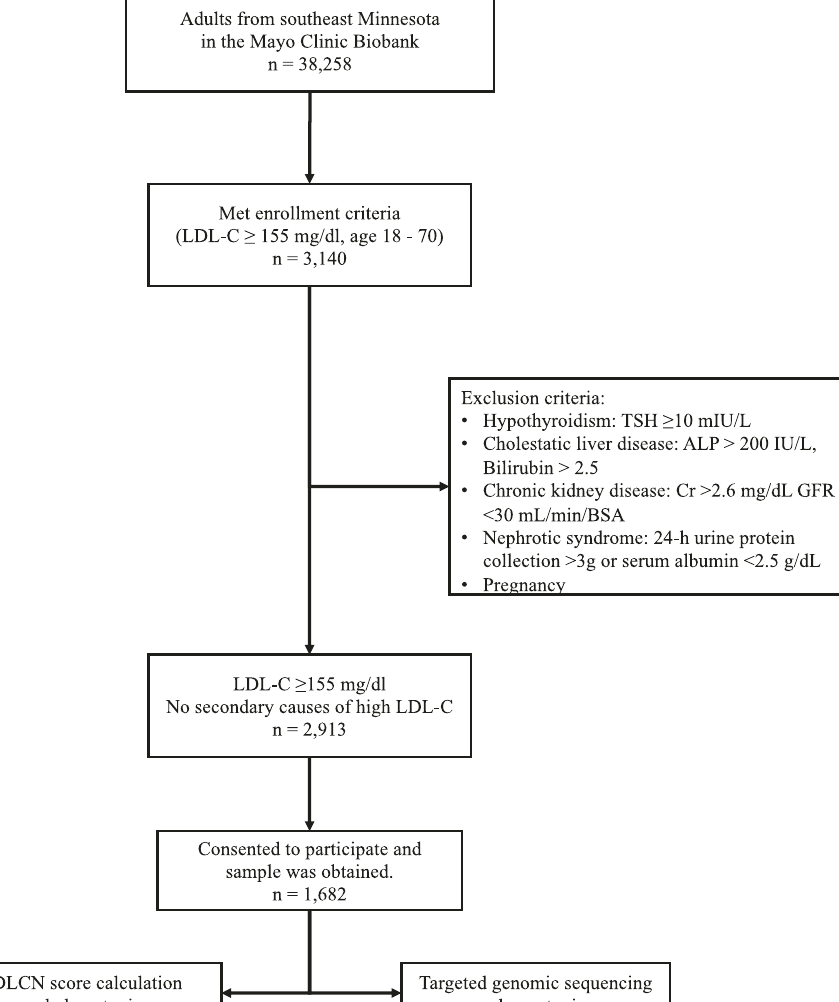
Fig. 1 Selection of the study cohort. ALP alkaline phosphatase, BSA body surface area, Cr creatinine, DLCN Dutch lipid clinic network, GFR glomerular fi ltration rate, LDL-C low-density lipoprotein cholesterol, TSH thyroid stimulating